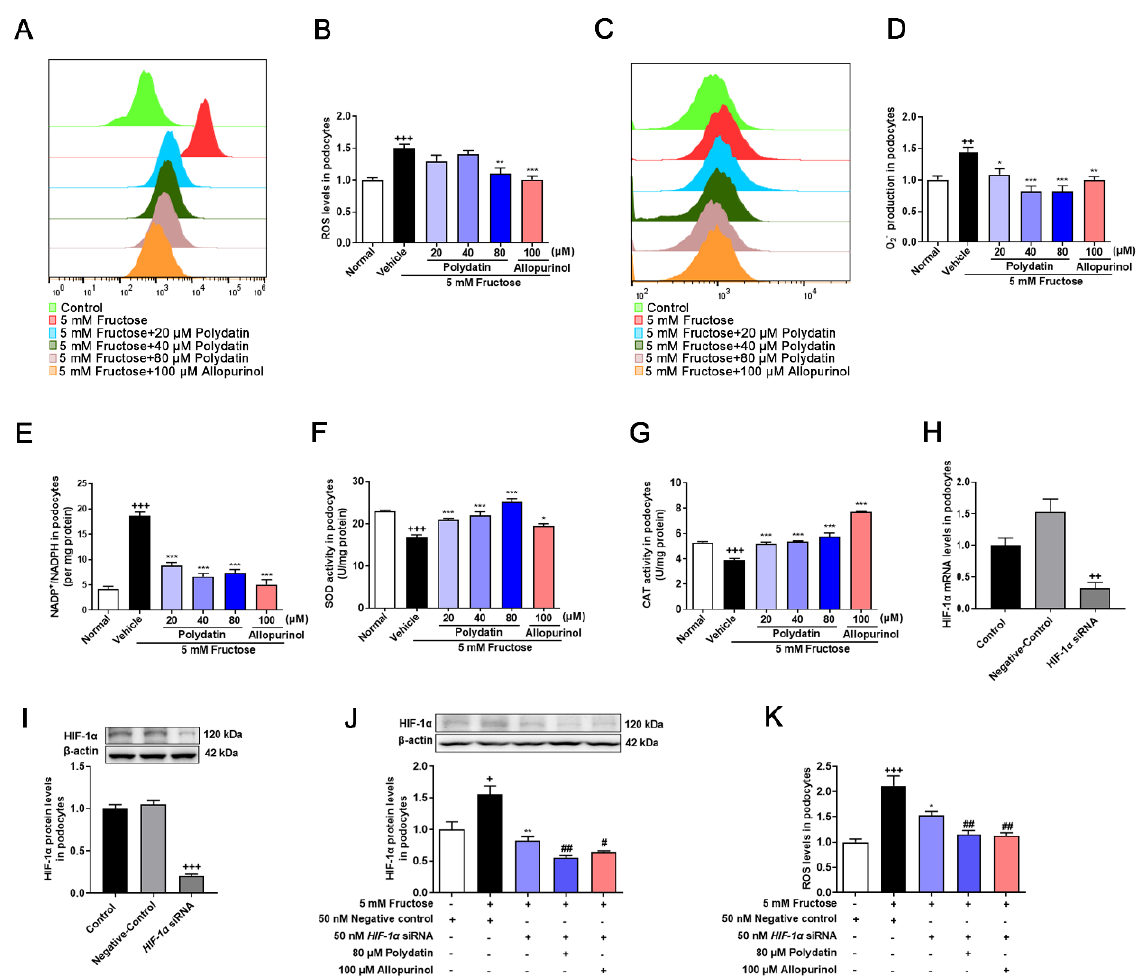
Figure 2. Polydatin inhibits HIF-1 α to ameliorate oxidative stress in high fructose-cultured podocytes. Podocytes were cultured with or without fructose (5 mM) in the presence or absence of polydatin (20, 40, and 80 µ M) or allopurinol (100 µ M). ( A , B ) ROS levels (24 h) were analyzed by labeling fluorogenic probe DCFH 2 -DA, evaluated by flow cytometry ( n = 3) and microplate reader ( n = 5) in podocytes. ( C , D ) O 2 − levels (24 h) were measured by fluorogenic probe DHE, evaluated by flow cytometry ( n = 3) and microplate reader ( n = 7–10) in podocytes. ( E – G) Intracellular NADP + and NADPH levels (48 h) ( n = 4) ( E ), SOD activity (48 h) ( n = 8–12) ( F ), and CAT activity (48 h) ( n = 6–9) ( G ) in podocytes were measured, respectively. ( H , I ) Relative mRNA and protein levels of HIF-1 α in podocytes transfected with HIF-1 α siRNA were detected by qRT-PCR ( n = 2–3) and Western blot ( n = 7–8). ( J ) Relative protein levels of HIF-1 α were detected in podocytes transfected with HIF-1 α siRNA and then incubated with or without fructose (5 mM), polydatin (80 µ M), and allopurinol (100 µ M) by Western blot ( n = 4). ( K ) ROS levels were analyzed in podocytes transfected with HIF-1 α siRNA and then incubated with or without fructose (5 mM), polydatin (80 µ M), and allopurinol (100 µ M) by labeling fluorogenic probe DCFH 2 -DA, evaluated by microplate reader ( n = 8–10). Data are expressed as the mean ± S.E.M. + p < 0.05, ++ p < 0.01, +++ p < 0.001 compared with normal control group or negative control group, * p < 0.05, ** p < 0.01, *** p < 0.001 compared with fructose vehicle group, # p < 0.05, ## p < 0.01 compared with fructose vehicle and HIF-1 α siRNA transfection group.